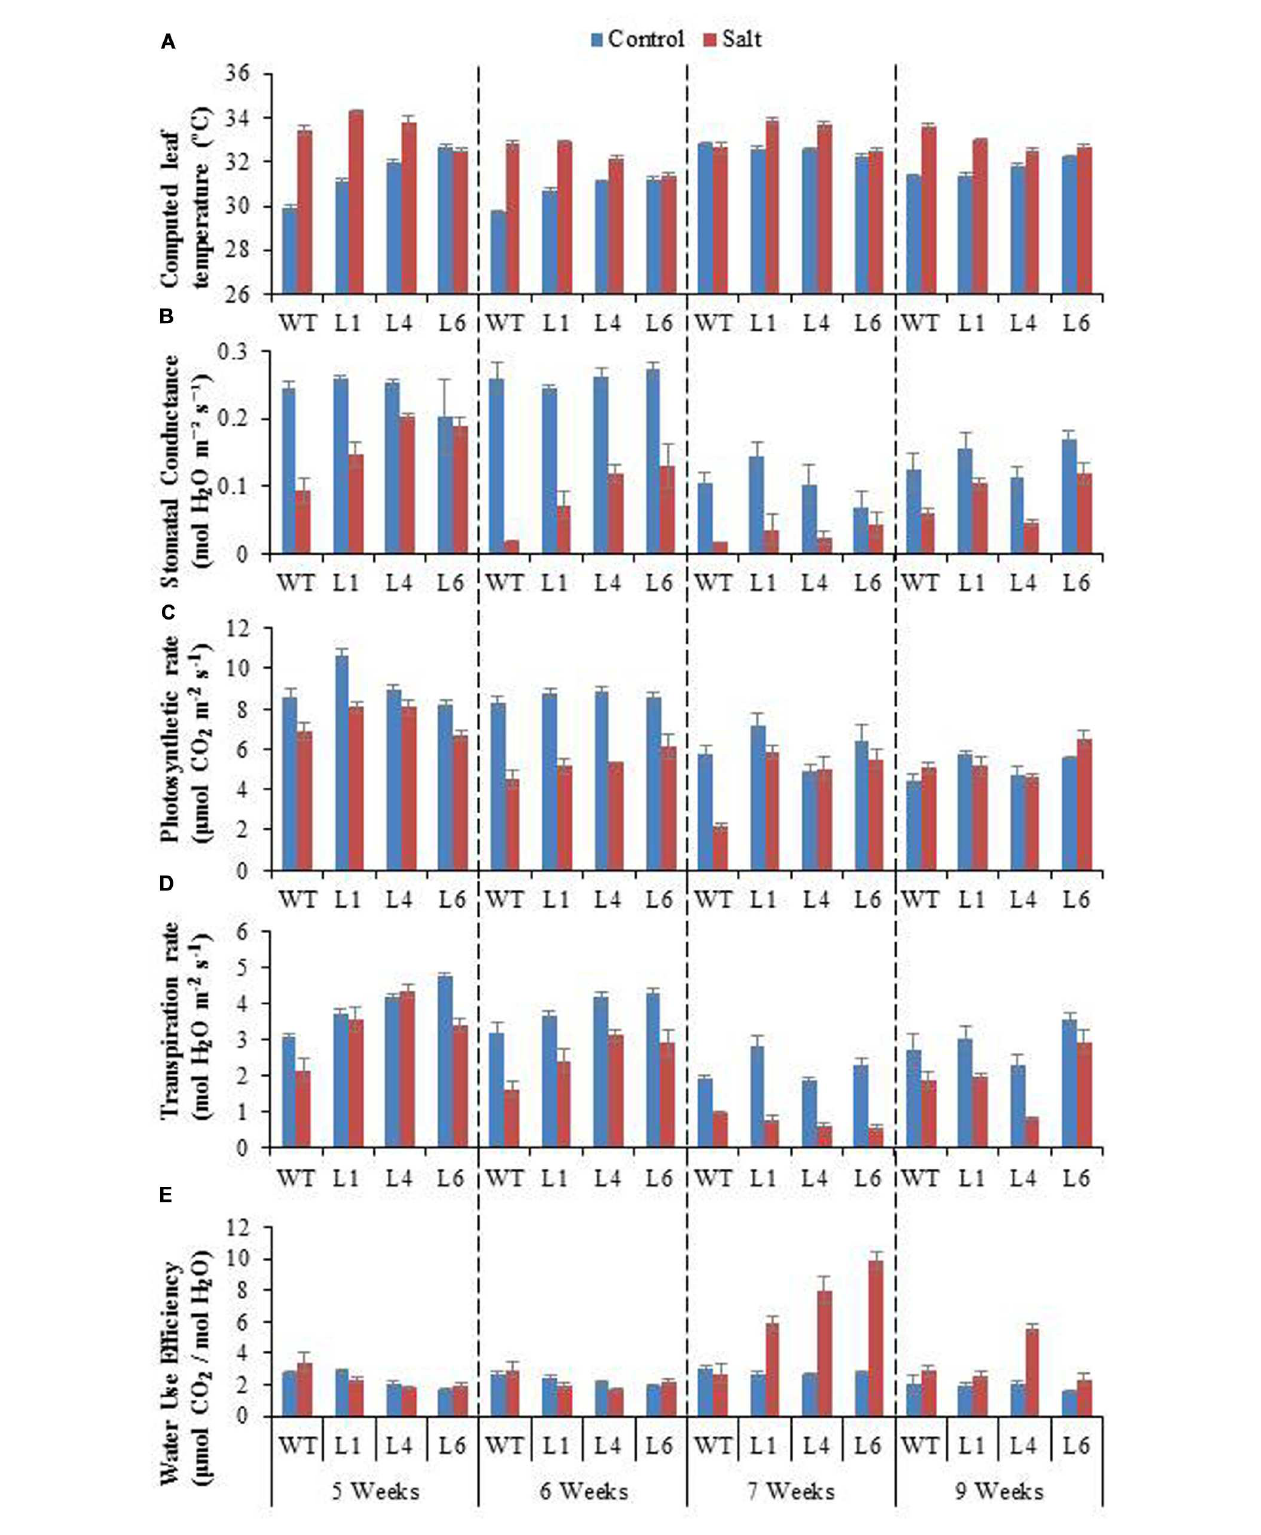
FIGURE 8 | Physiological analysis of WT and JcPR-10a transgenic lines (L1, L4, and L6) in response to the gradual exposure of stress (5–7 weeks) and after restoration (9 weeks). (A) Computed leaf temperature, (B) Stomatal conductance, (C) Photosynthetic rate, (D) Transpiration rate and (E) Water use efficiency